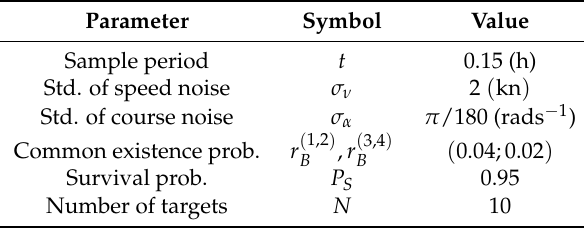
Table 2. Parameters of the Dynamic